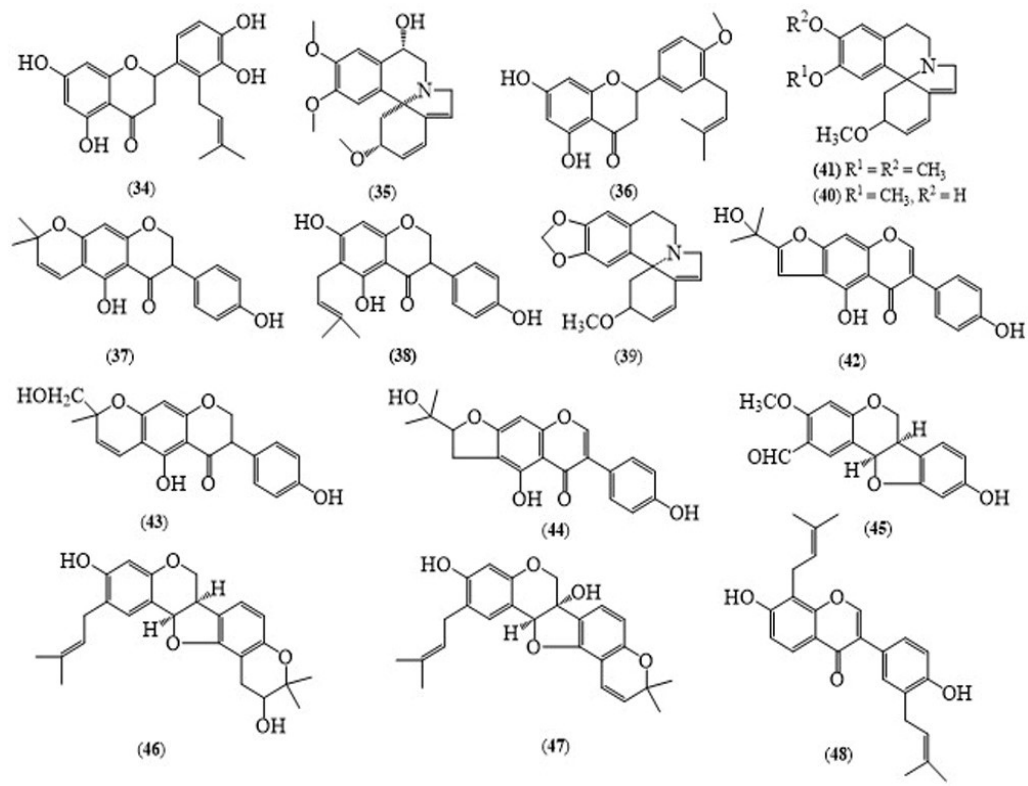
Figure 4. Structures of selected compounds isolated from Erythrina suberosa.